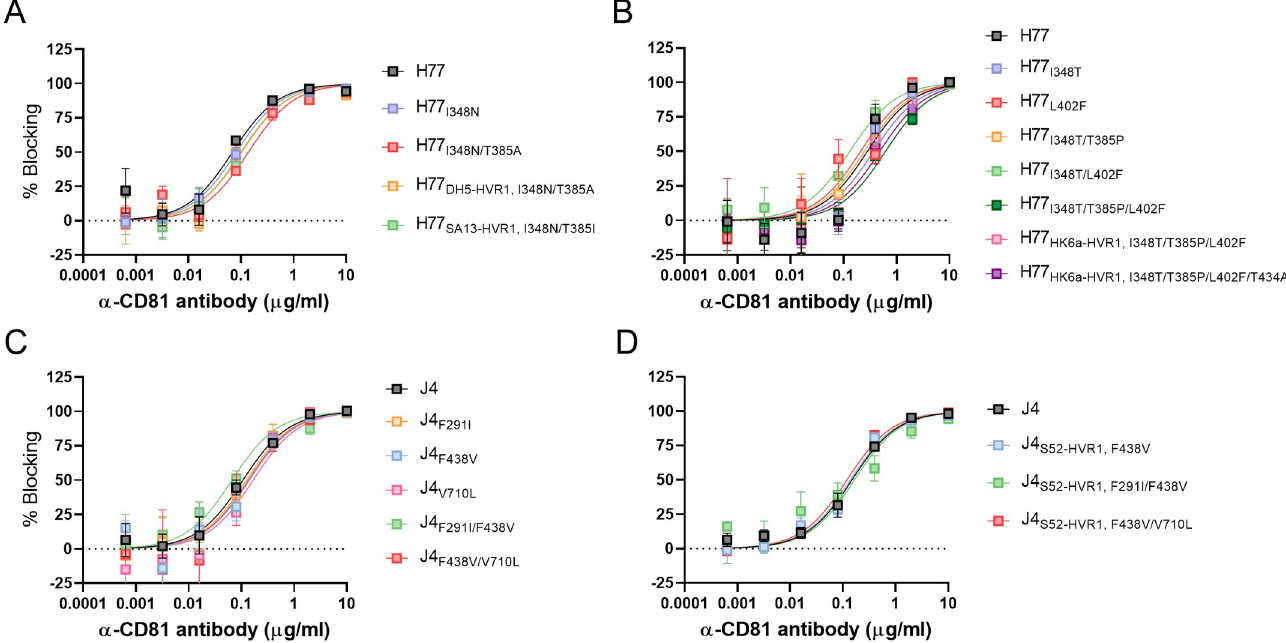
Fig 11. HVR1-swap compensatory E1/E2 substitutions do not affect CD81 entry dependency. HVR1-swap adaptive substitutions effect on H77 (A and B) or J4 (C and D) dependency on CD81. Huh7.5 cells were incubated with a 5-fold dilution series of anti-CD81 mAb JS-81 that specifically blocks the interaction between HCV and CD81 in four technical replicates with eight technical replicates of virus only and four technical replicates of control antibody. 48 hours post-infection the cells were immunostained for HCV antigen, and the number of FFUs/well was counted and normalized to the mean count of wells with virus only. Error bars represent standard deviation. The data were analysed using three-parameter sigmoid dose-response curves using Graphpad Prism v8.0.0 with bottom constraints set to 0.